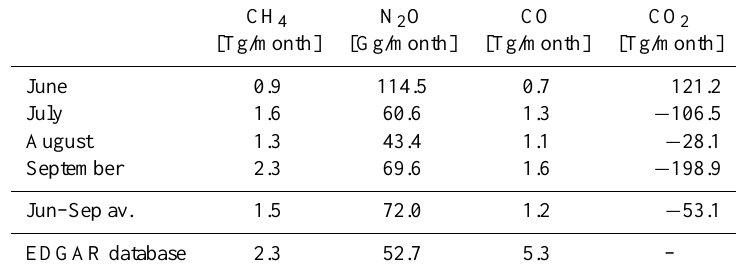
Table 2. Estimates of total net fluxes for CH 4 , N 2 O, CO, and CO 2 based on India’s assumed SF 6 emissions in 2005. Error estimates are ∼ 50% for all tracers. Emission data from the EDGAR inventory are for India in 2005 (v4.0, CH